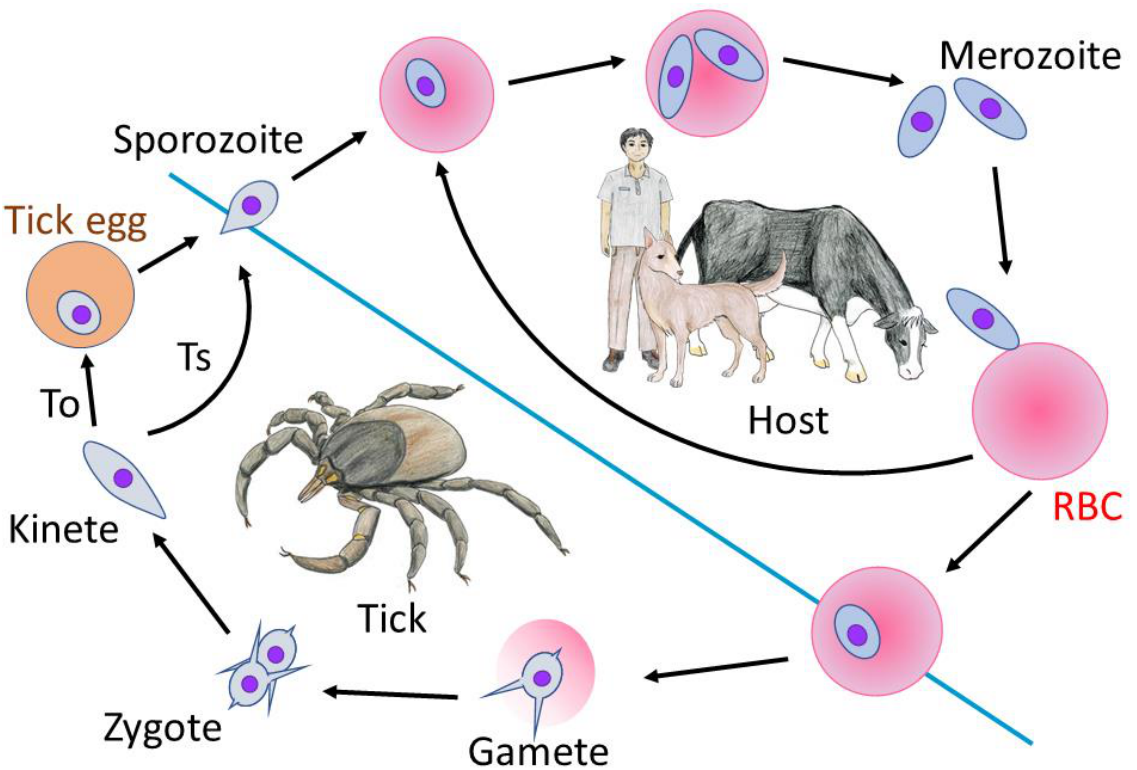
Figure 1. The life cycle of Babesia spp. The infection starts when Babesia sporozoites are injected into the mammalian host during the blood meal and directly invade and multiply in the RBCs. A subset of the parasite population transforms into gametocytes in the host or upon taken up by the tick where they produce gamete in the tick midgut. Gametes produce diploid zygotes following fertilization. Zygotes invade midgut epithelium and undergo meiotic division which produces kinetes. Kinetes invade and multiply in several organs including salivary glands which results in transstadial transmission (Ts). In most of Babesia spp. except B. microti , kinetes invade ovaries and eggs which results in parasite transmission into offspring (transovarial transmission, To).